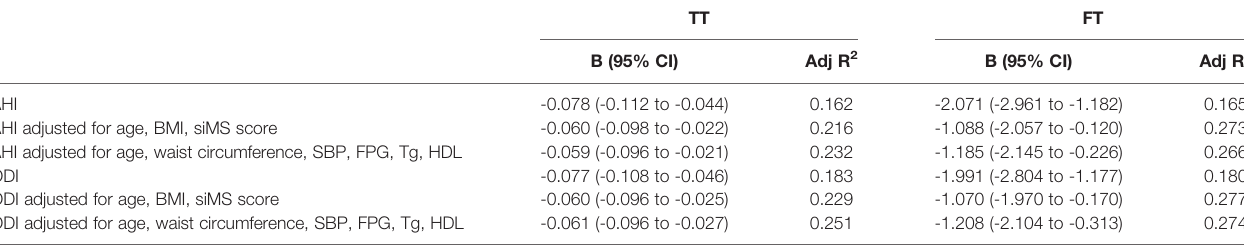
TABLE 3 | Multiple linear regression model for prediction of total testosterone (TT) and free testosterone (FT).